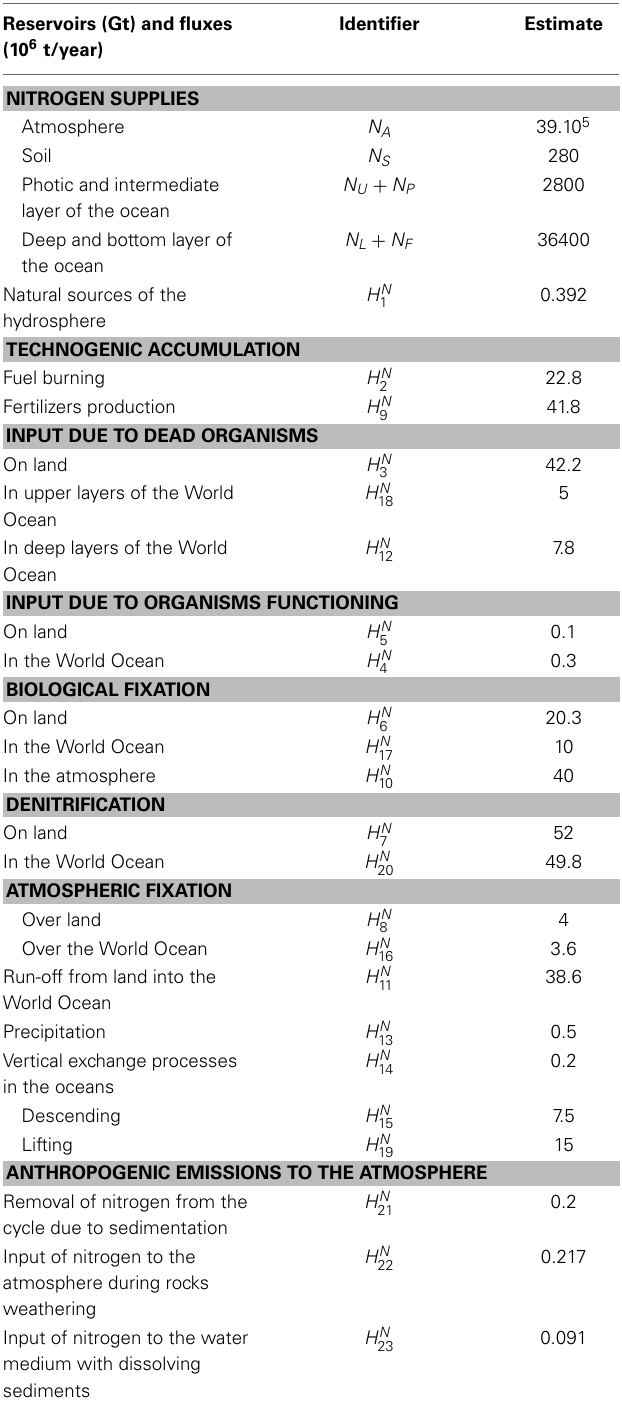
Table 2 | Characteristics of reservoirs and fluxes of nitrogen in the biosphere (Figure 7